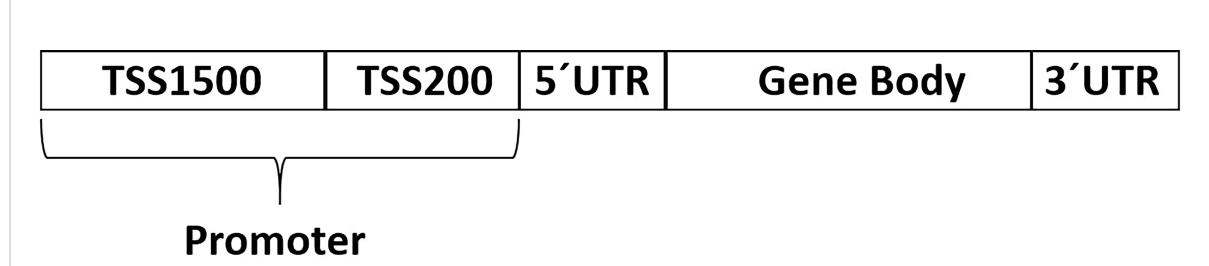
FIGURE 1 Gene regions selected for methylation analysis using In fi nium MethylationEPIC BeadChip microarrays of the cassette of 178 DNA repair genes in EOC patients (N =